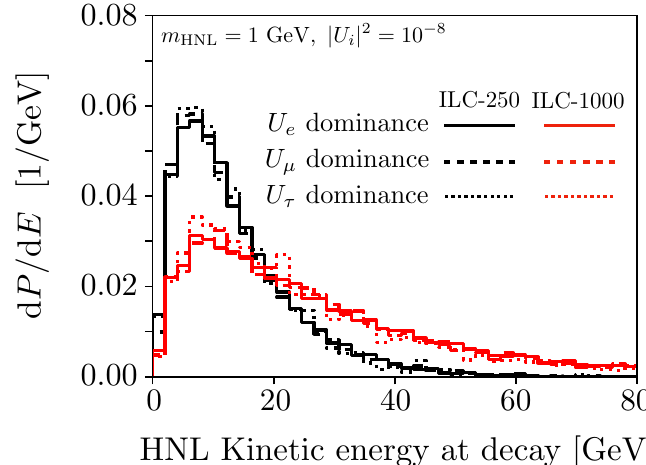
Figure 6 . The normalized kinetic energy distribution of HNLs when they decay inside the decay volume. The mixing angle squared is 10 − 8 , and the mass is 1 GeV. The red (black) lines are for